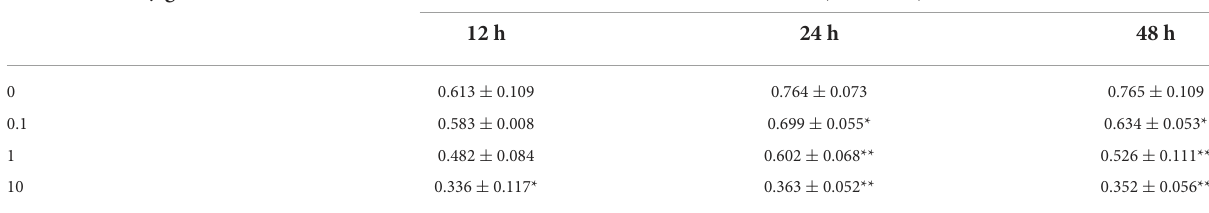
TABLE 3 Effect of LPS on IPEC cell proliferation.